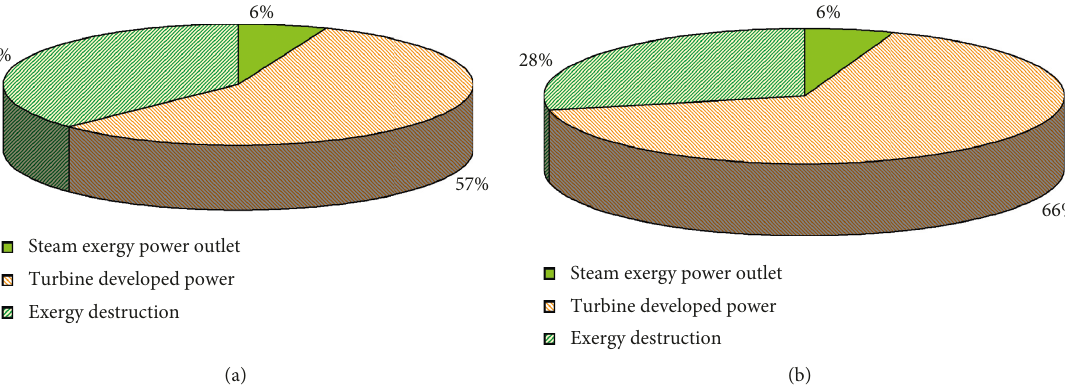
Figure 11: Distribution of steam turbine exergy power inlet for operating point 8 in exploitation (a) and at the maximum exergy efficiency